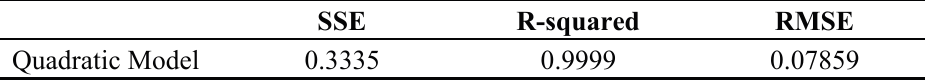
Figure 5. Thermistor curve fitting based on the quadratic model. Table 2. Curve fitting accuracy of thermistor